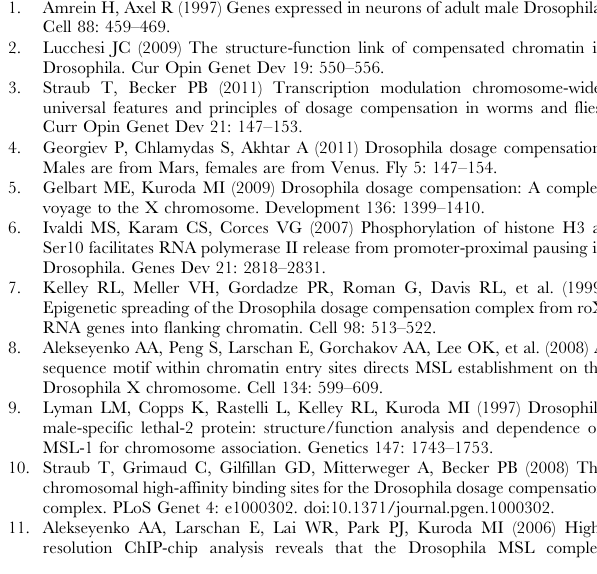
Table S1 URL of the modENCODE datasets used in this study. (DOC) Table S2 The number and proportion of non-functional MREs eliminated from each chromosome using the best combination of features, best individual features only (H3K36me3 or JIL-1), or GC content only. Chromatin features can eliminate over 85% of the non-functional MREs on autosomes, and over 75% of non- functional MREs on X. The high proportion of false positives on the X chromosome indicates that there are likely more true MSL binding sites than the set of sites we used in this study. (DOC) Table S3 Chromosome-wide enrichment of many active chromatin marks on the male X chromosome compared to autosomes. The mode of the ChIP enrichment density profile is calculated for each major chromosome arm in S2, BG3 and Kc cells. The mode of the X chromosome enrichment is compared to the average of the modes of autosome enrichment in each sample. We observe that the mode of enrichment density is similar in all profiles in Kc cells. In contrast, there is enrichment in many active chromatin marks on the male X chromosome compared to autosomes, as well as depletion of core and linker histones on the male